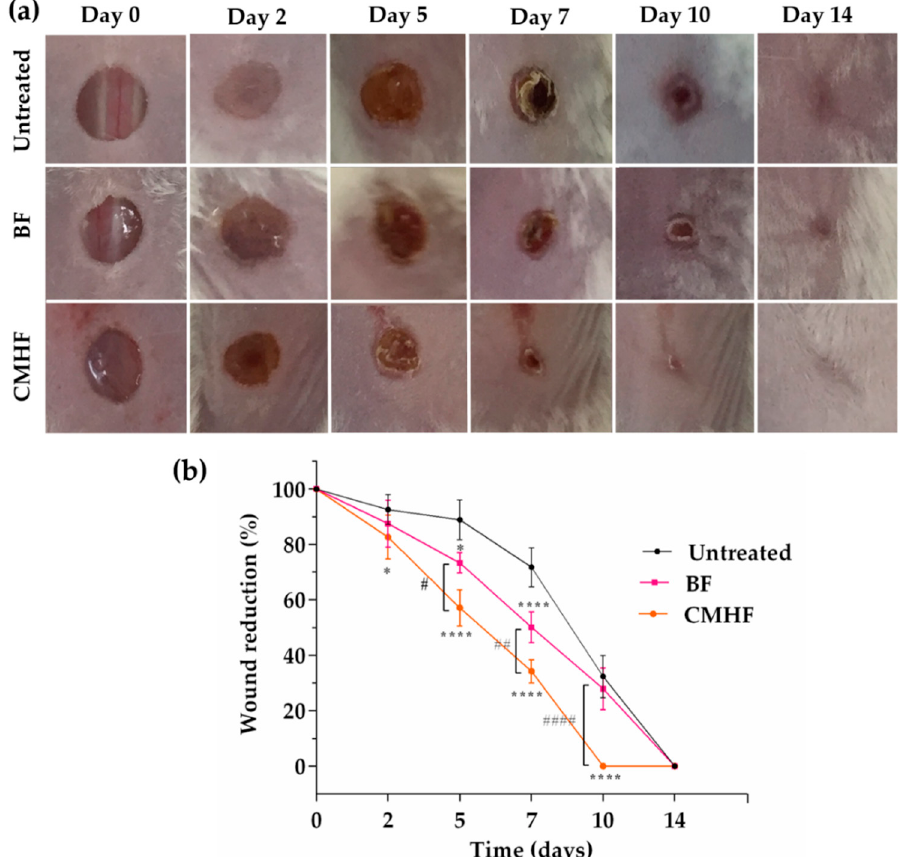
Figure 7. In vivo wound healing study performed on days 0, 2, 5, 7, 10, and 14. ( a ) Representative images of the wound healing process of the untreated, BF, and CMHF groups. ( b ) Wound closure rate measured on days 2, 5, 7, 10, and 14 after treatment with BF and CMHF. Data are expressed as percentage of wound size reduction in comparison with the original wound (day zero). **** p < 0.0001 and * p < 0.05 compared to untreated group and #### p < 0.0001, ## p < 0.01, and # p < 0.05 compared to BF group using ANOVA followed by Tukey test ( n = 5).